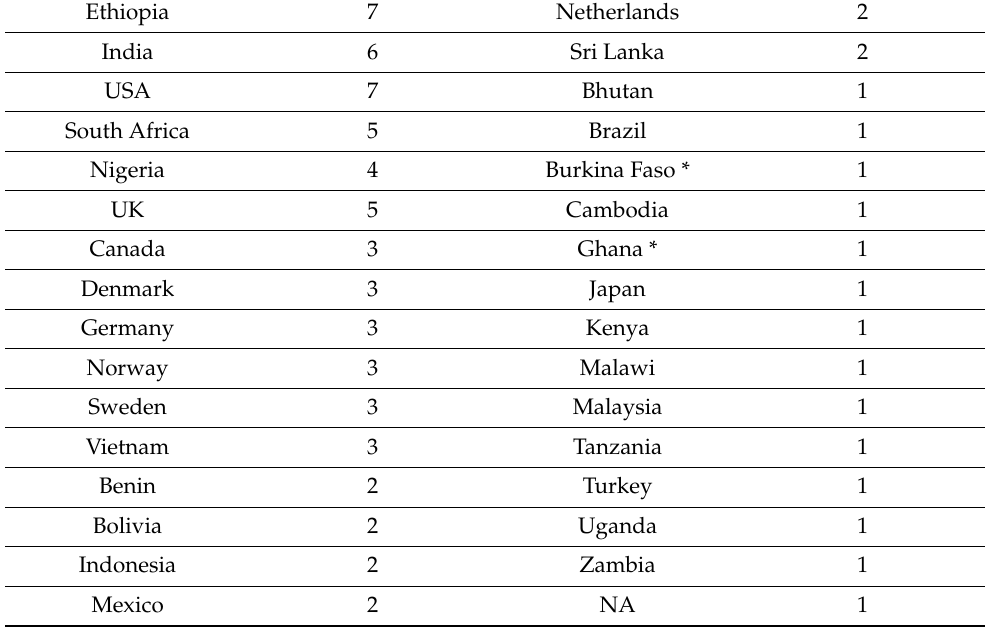
Table 4. Location of first